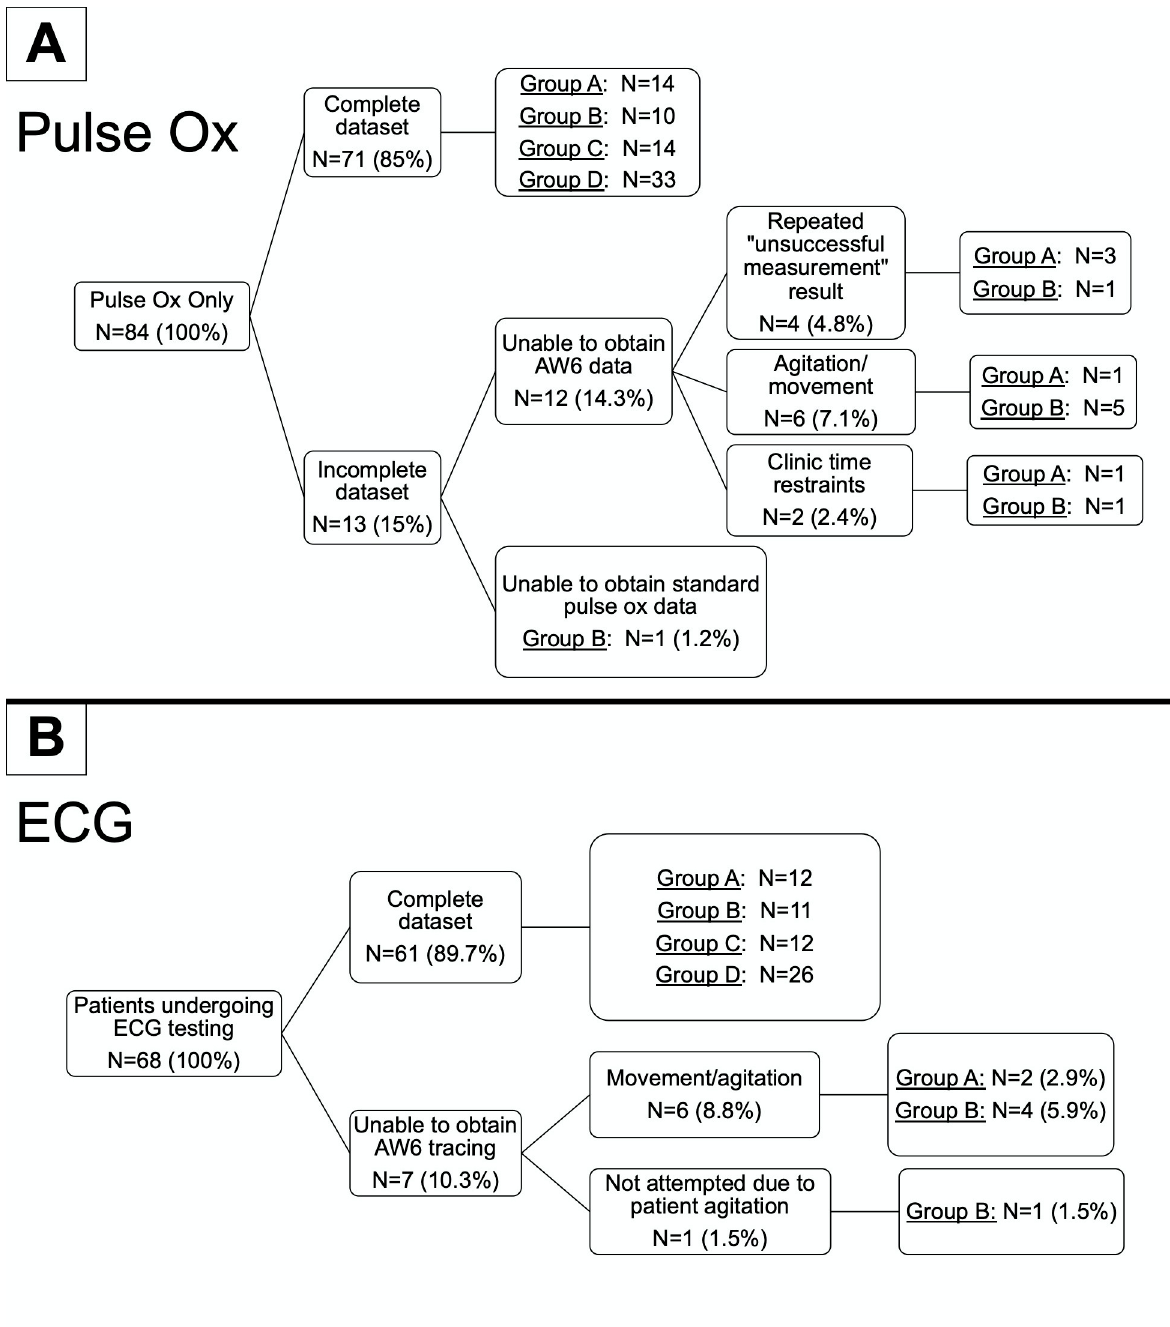
Fig 1. Patient flowchart for pulse oximetry (A) and ECG (B) data. Abbreviations: AW6 = Apple Watch 6. Group A = 3-10kg, Group B = > 10-18kg, Group C = > 18-32kg, and Group D = >